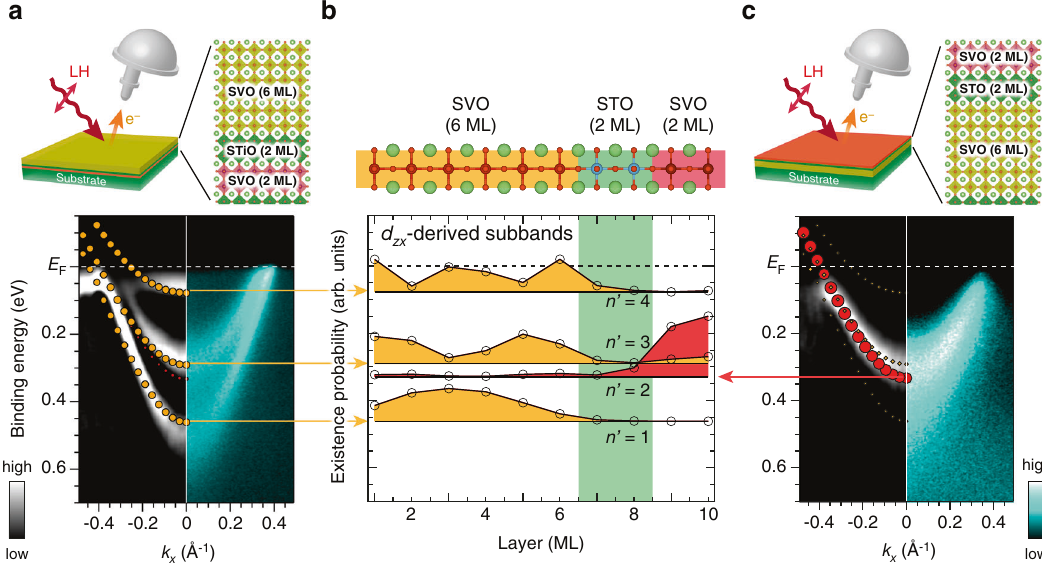
Fig. 3 Subband structures formed at the V 2 T 2 V 6 heterostructure. a , c Comparison of ARPES images taken near the Γ point with the DFT calculations for V 6 T 2 V 2 ( a ) and V 2 T 2 V 6 ( c ) double QWs. Raw ARPES intensity plots are shown on the right half side and peak-enhanced plots (see Supplementary Note 8) on the left-half side, together with the DFT calculation. As shown in the schematic layout on the top, electrons near the surface (~0.4 – 0.6 nm) are detected in the ARPES measurements. Since only d zx -derived subbands are detected in this experimental con fi guration (see Supplementary Note 7), the corresponding subband with predominant d zx character ( fi lled circles) is presented in the calculation for comparison (the subbands for all t 2 g states are shown in Supplementary Fig. 26). The probability of the electron being detected by ARPES is represented by the size of the fi lled circles. b Existence probabilities for respective d zx -derived subbands, which are calculated by Mulliken population analysis, are plotted along the z direction for the V 2 T 2 V 6 heterostructure. The baselines of the existence probabilities (solid black lines) correspond to the quantization energies (subband minimum energies). The existence probability of bonding n ′ = 2 states (red hatched) has central weight at the 2-ML QW, while that of antibonding n ′ = 3 states (yellow hatched) at the 6-ML QW, representing their original